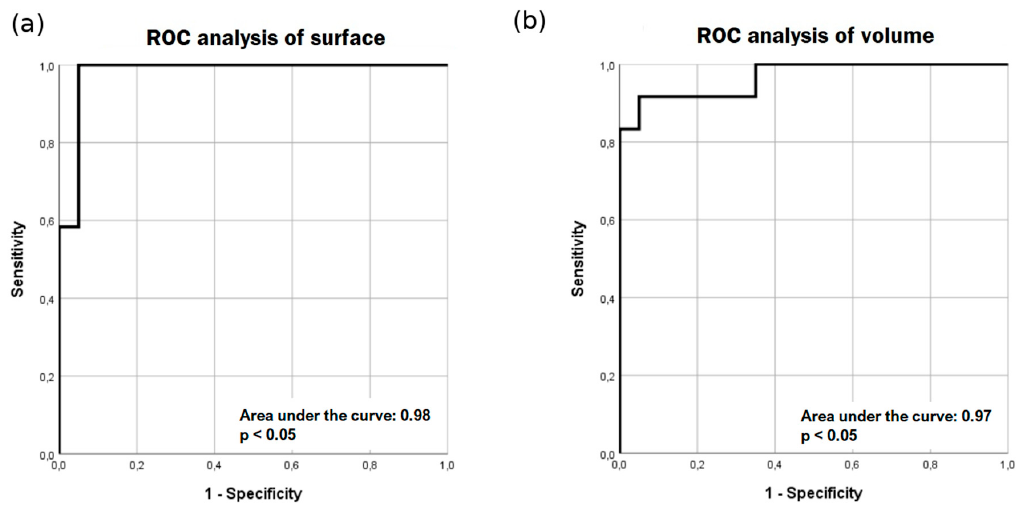
Figure 5. Receiver operating characteristic (ROC)analysis of surface ( a ) and volume ( b ) results. ROC analysis yields high sensitivity and specificity for manual segmentation of surface area ( a ) and semi-automatic ( b ) segmentation of volume.